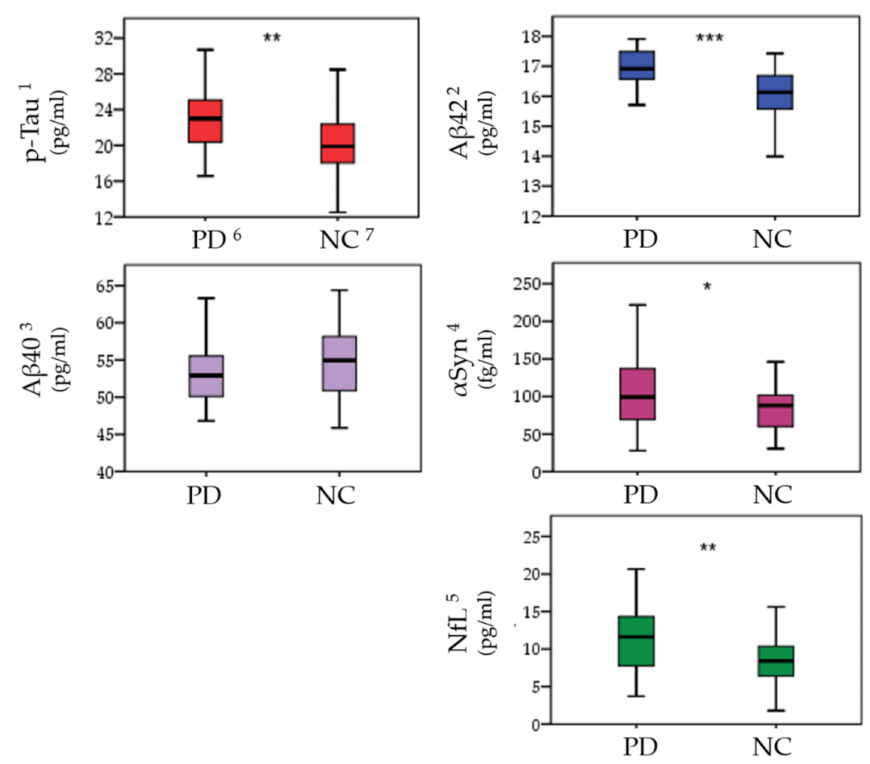
Figure 1. Analysis of plasma misfolded proteins levels between Parkinson’s patients (PD) and normal controls (NC). Misfolded protein levels are presented as mean (pg/mL or fg/mL) ± standard deviation. Plasma misfolded protein level data were compared with ANCOVA after controlling age and sex. 1 p-Tau (phosphorylated-Tau); 2 A β -42 (Amyloid β -42); 3 A β -40 (Amyloid β -40); 4 α -Syn ( α -synuclein); 5 NfL (Neurofilament light chain); 6 PD (Parkinson’s disease); 7 NC (Normal control); * indicates Benjamini–Hochberg adjusted p -values < 0.05, ** p < 0.01, *** p < 0.001.